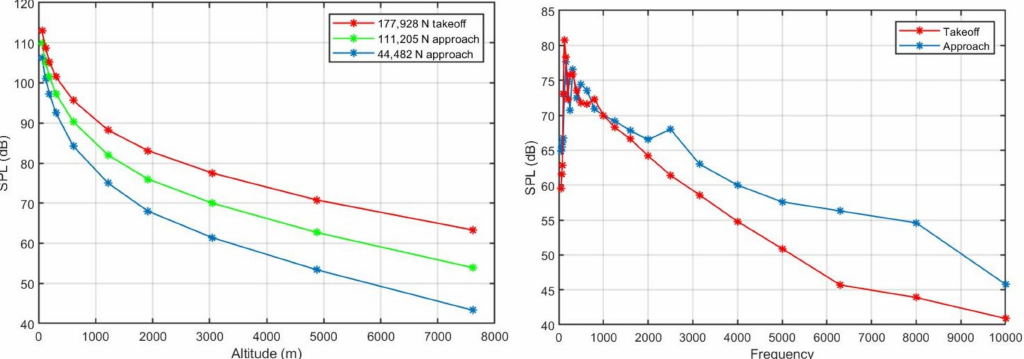
Figure 8. Variation of SPL with altitude and